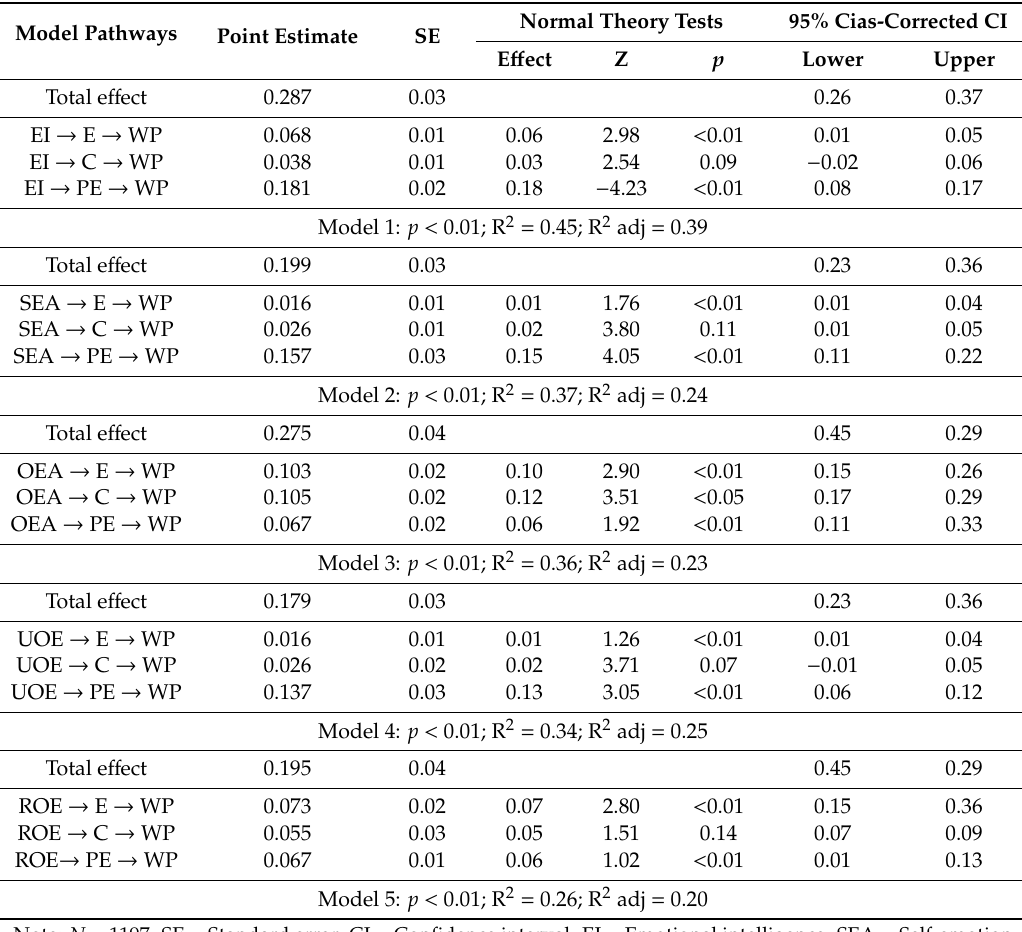
Table 3. Multiple mediating analyses of burnout dimensions.